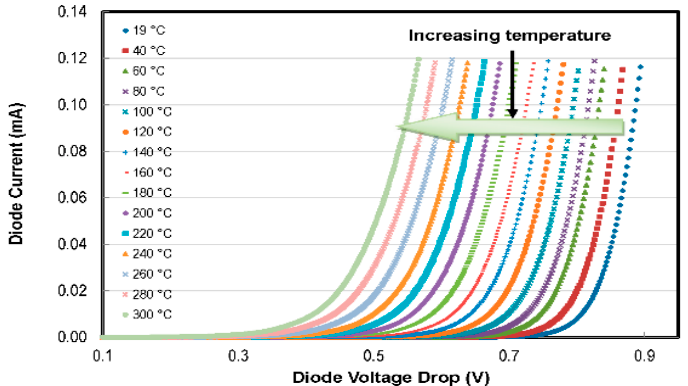
Figure 10. Shifting of the I-V curve of a thermodiode temperature sensor with increasing temperature.